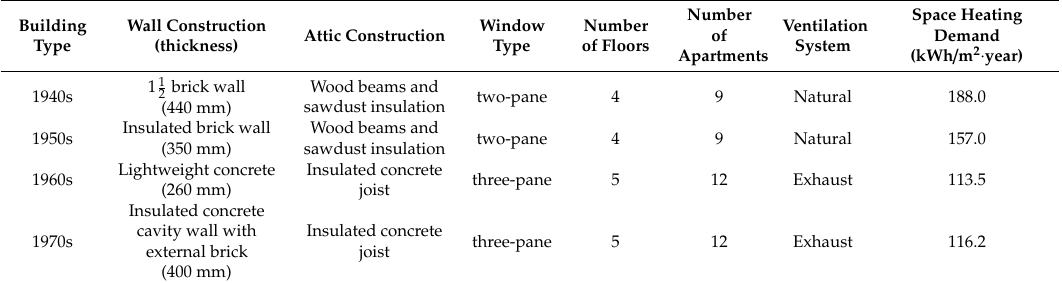
Table 3. Construction and ventilation systems of the analyzed building types.